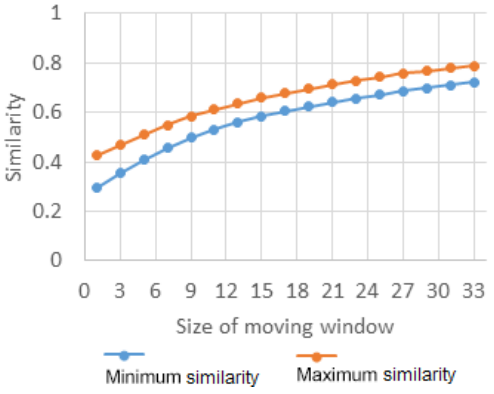
Figure 3. Maximum and minimum similarities between simulated and observed maps for the year